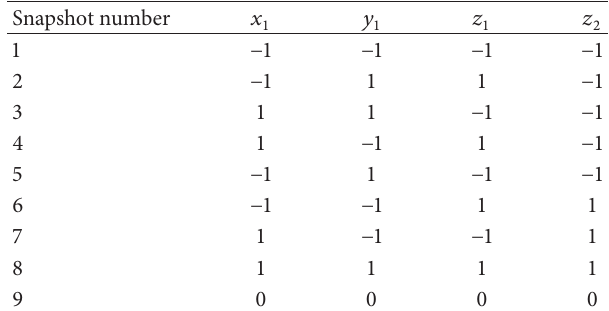
Table 3: DrivAer model. Two-level fractional factorial design for the initial snapshot